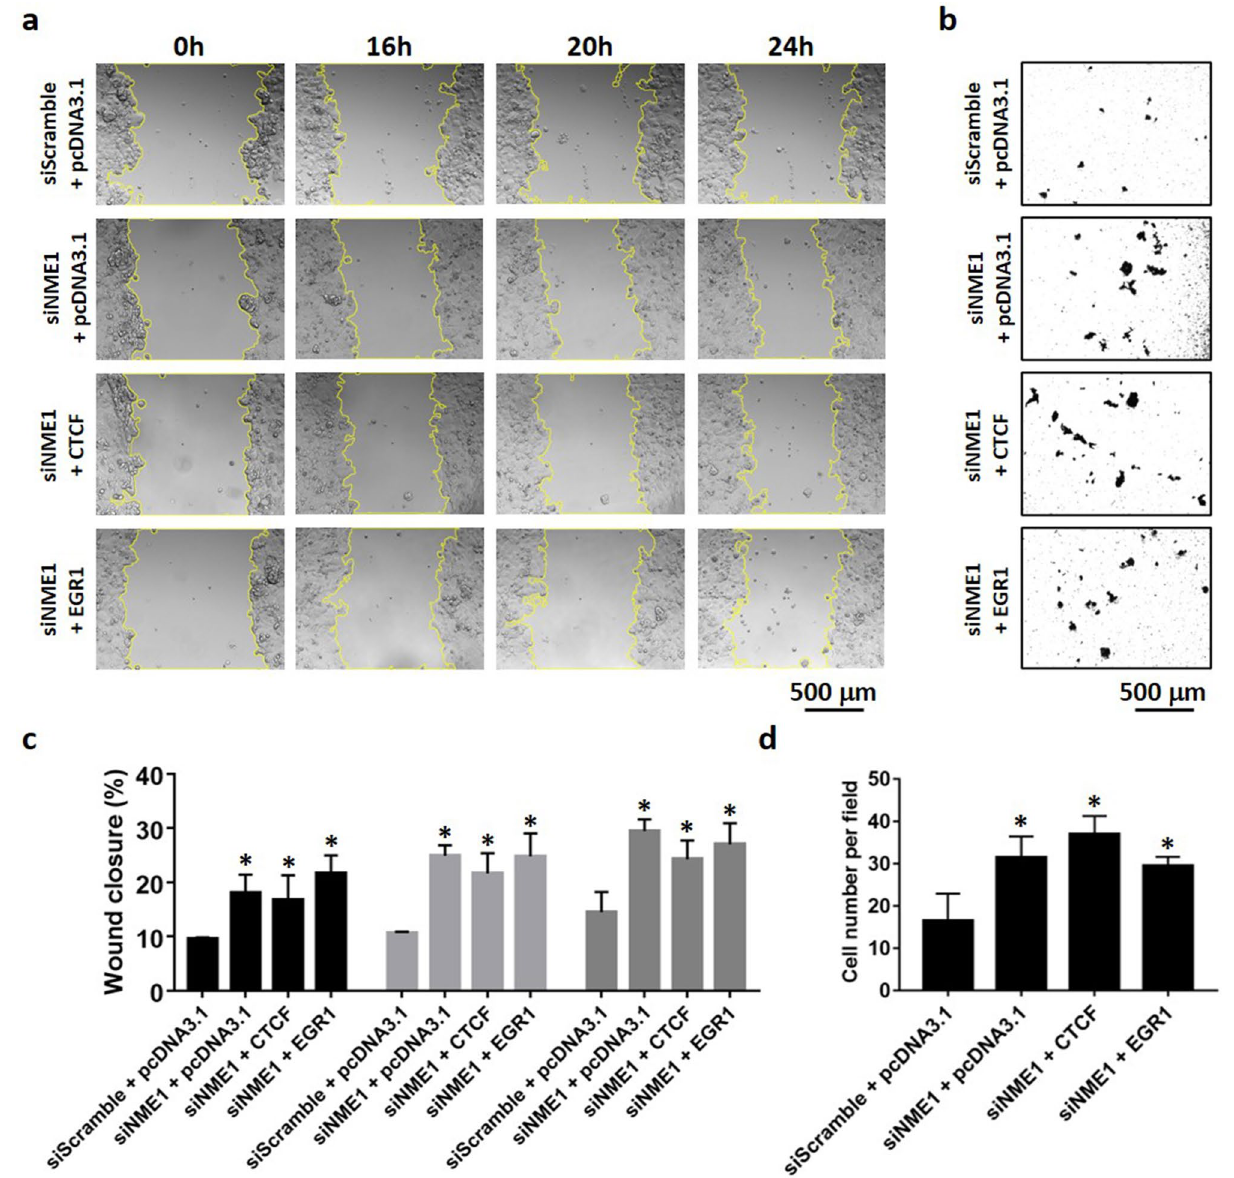
Figure 9. Cell migration of MCF-7 cells upon Nm23-H1 knockdown and CTCF or EGR1 overexpression. ( a , c ) Transiently transfected cells were grown to full confluency and scratched with a yellow pipette tip. Photos were taken at different time points with a microscope at ×10 magnification. Cell migration was quantified as percentage of wound closure using ImageJ and MRI Wound Healing Tool plugin. ( b , d ) Transiently transfected cells were seeded into the upper chamber of Transwell inserts and allowed for migration for 48 h. Photos were taken with a microscope at ×10 magnification and the number of migrated cells was quantified using ImageJ. Data represent the mean and standard deviation of three independent trials. *Significance with siScramble + pcDNA3.1, p <